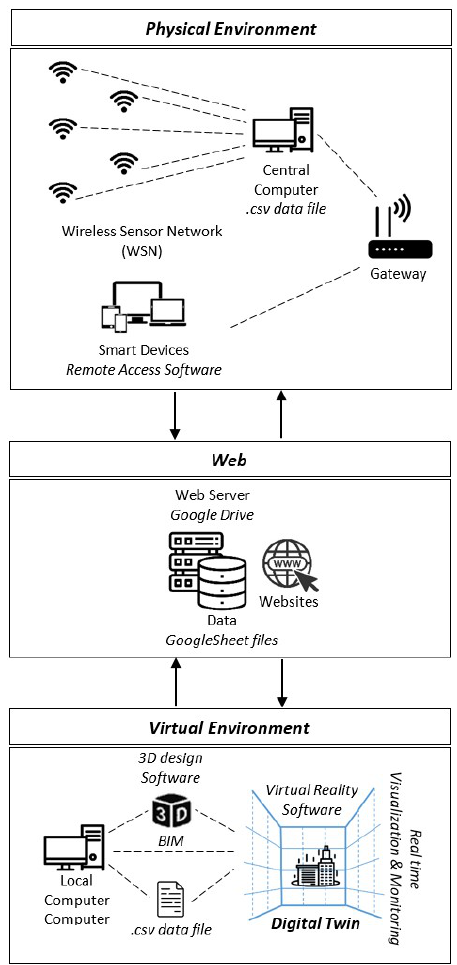
Figure 2 . Overview of the developed